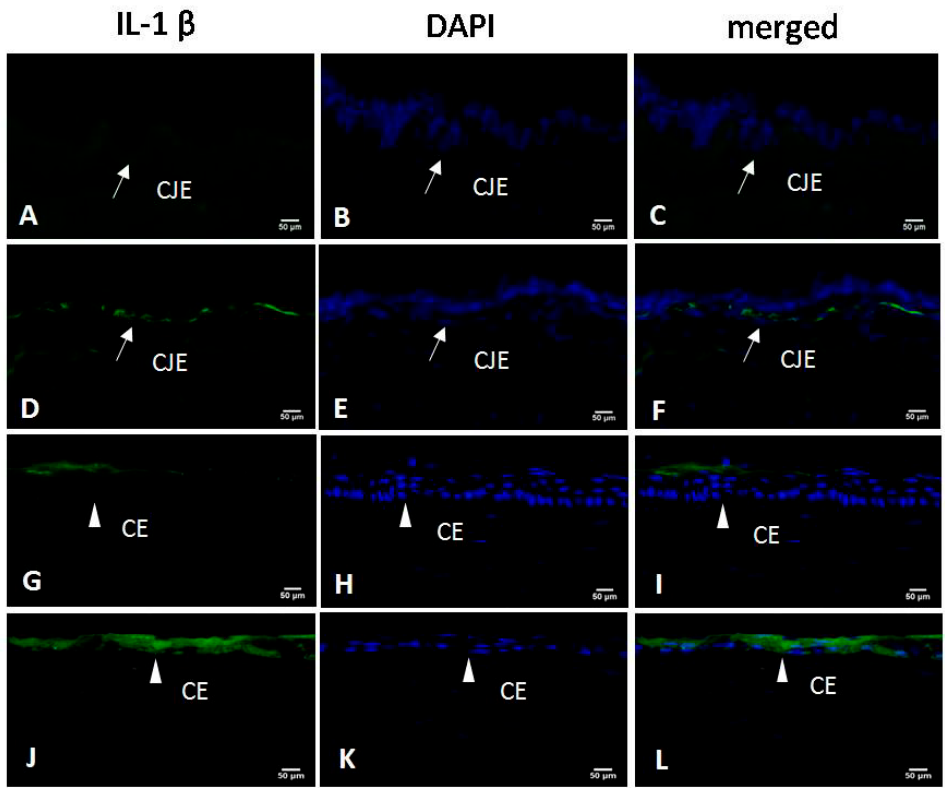
Figure 4. Immunofluorescence staining with interleukin-1 β (IL-1 β )-specific antibodies in the conjunctival epithelium (CJE) and corneal epithelium (CE) (IL-1 β staining: green; nuclear staining: blue). In the control group, IL-1 β staining was very weak in the CJE ( A – C ) and localized only to the surface of the CE ( G – I ). CJE and CE were thinner in the DED group, in which the basal layer of the CJE ( D – F ) and the entire CE ( J – L ) stained positive for IL-1 β (×400). CJE: conjunctival epithelium (white arrow); CE: corneal epithelium (white triangle). Scale bar = 50 μ m.